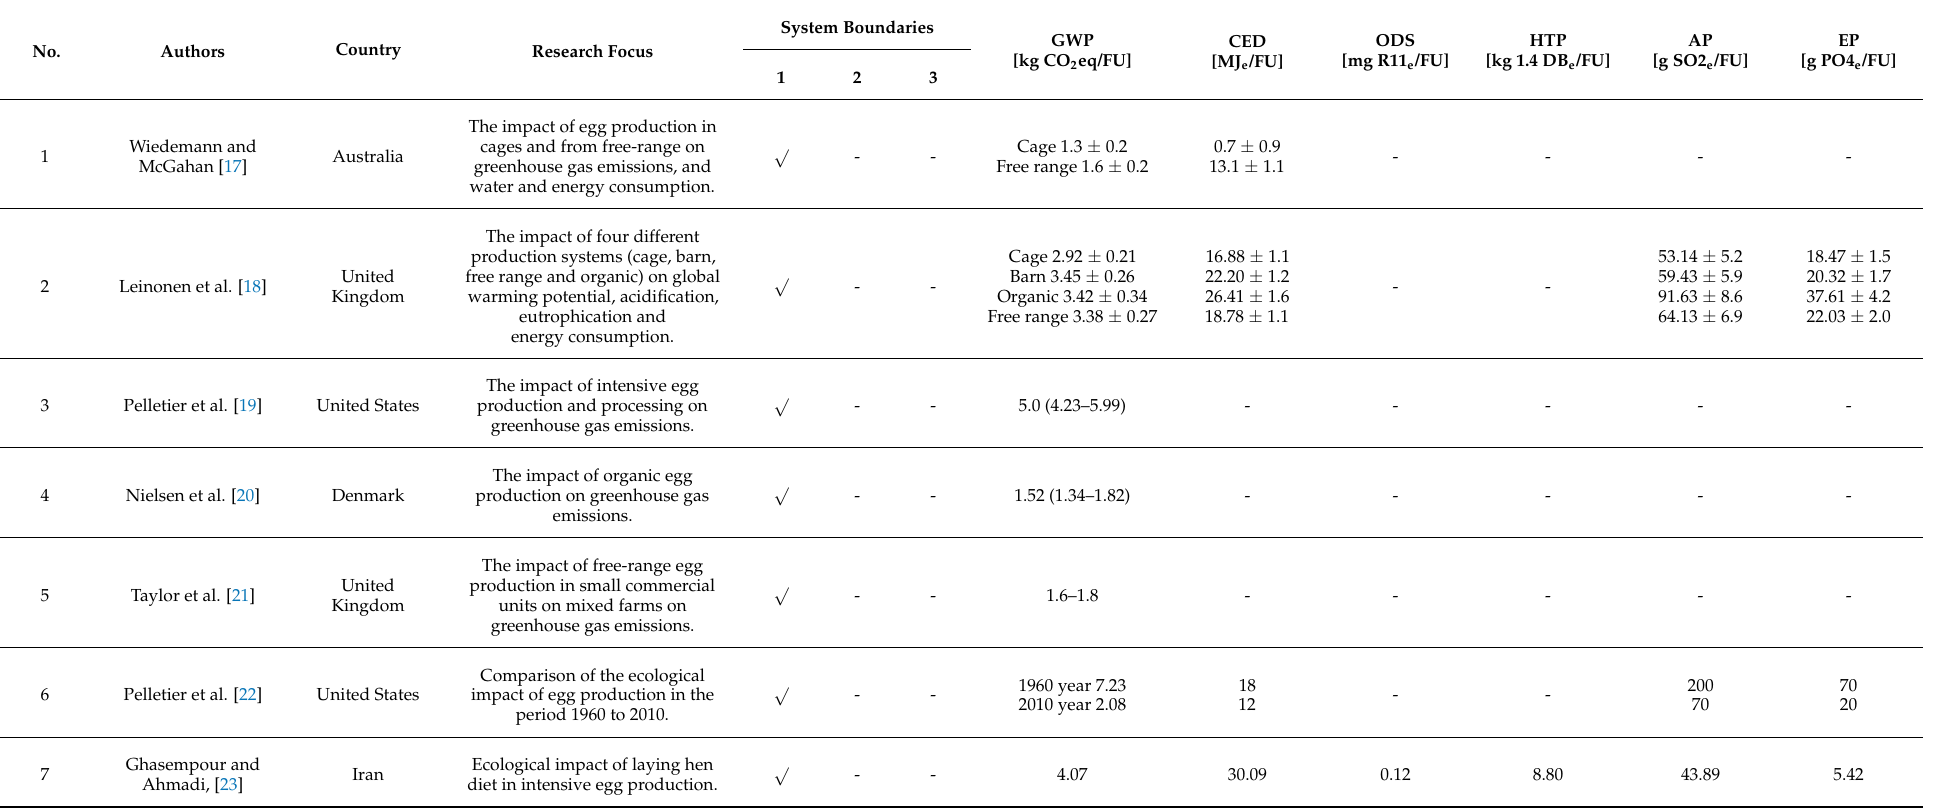
Table 1. An overview of Life Cycle Assessment (LCA) research in the egg chain in the last ten